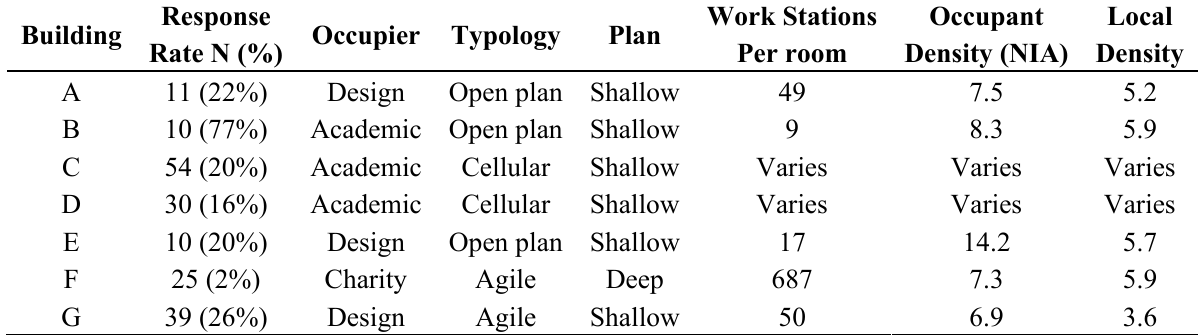
Table 3 . Overview of the studied buildings showing office type and occupant